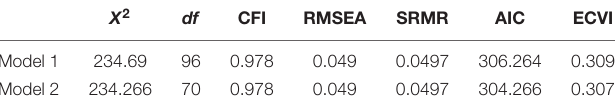
TABLE 2 | Fit indices of model 1 and model